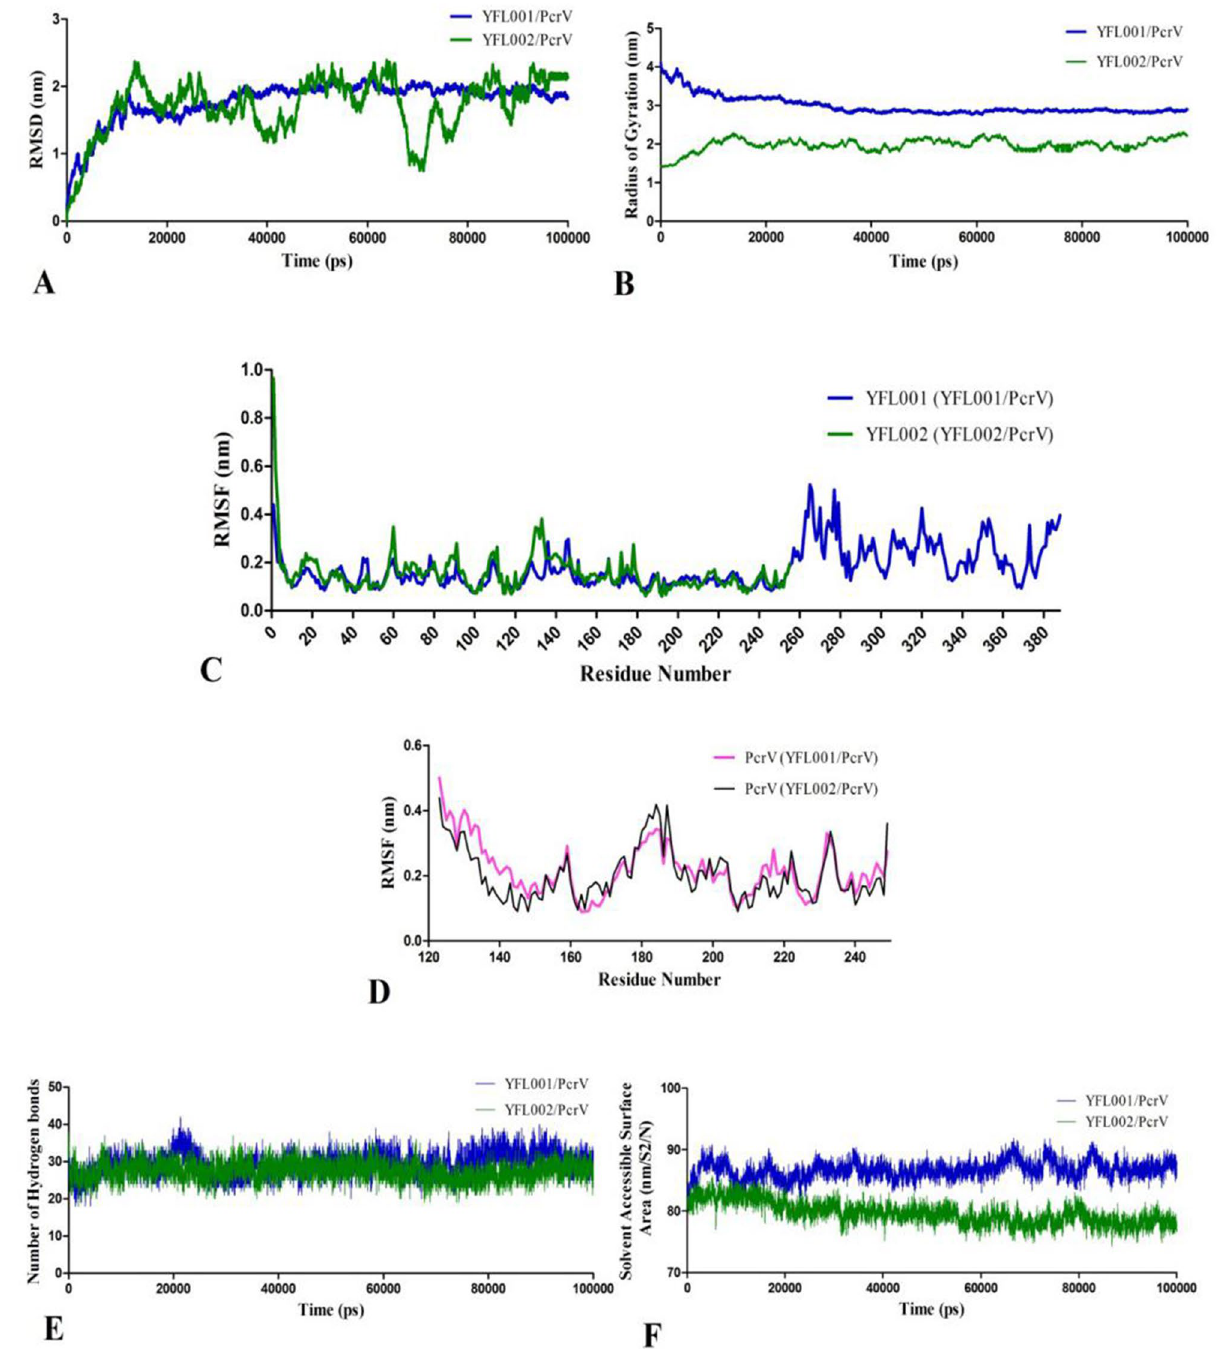
Figure 4. MD simulations of YFL001/PcrV and YFL002/PcrV complexes: (A) RMSD; ( B ) RoG; ( C ) RMSF values of YFL001 and YFL002 molecules; ( D ) RMSF values of PcrV antigen; ( E ) Number of H-bonds; ( F ) SASA plots. Plots of YFL001 and YFL002 in their complexes with PcrV are shown in blue and green, respectively. Plots of PcrV within the complexes are in pink and black, Proton chemical shifts of the amino acids obtained from the NMR peaks were comparable with the protein NMR table (available on www. triton. iqfr. es). The slight shift appeared in the NMR peaks may be due to the dif- ferent folding characteristics of the two recombinant molecules (Table 4). Biological activity of the recombinant proteins. Inhibition of PA induced RBC cell lysis. A specific PCR was performed (data not shown) in which a 428 bp PCR product could represent the presence of the exoU gene. To assess the biological activity of the recombinant proteins, inhibition of ExoU + PA strains in RBC lysis